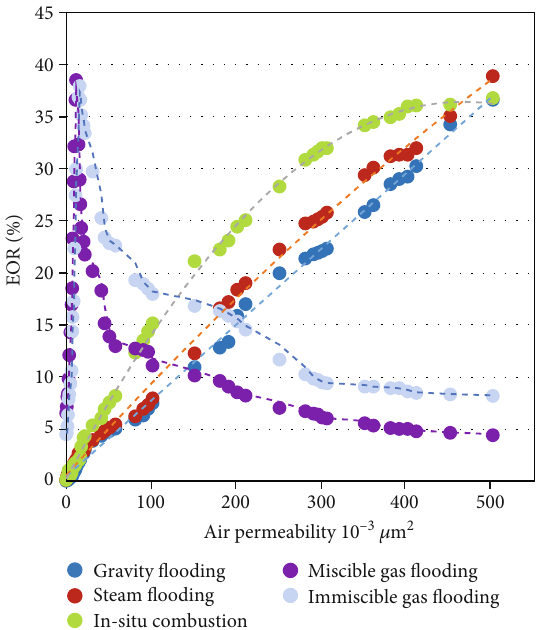
Figure 7: The e ff ect of air permeability on